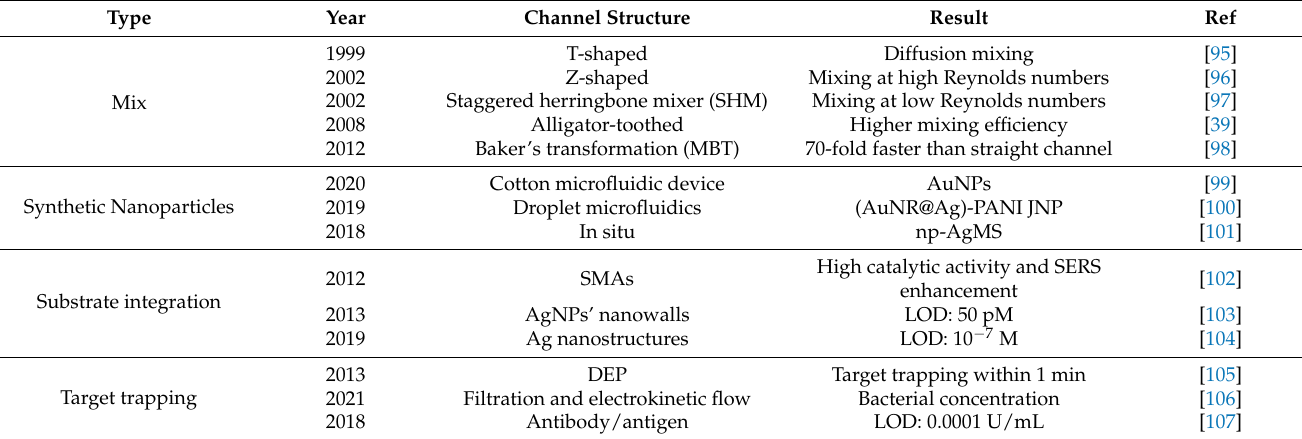
Table 2. Key factors for combining microfluidics with